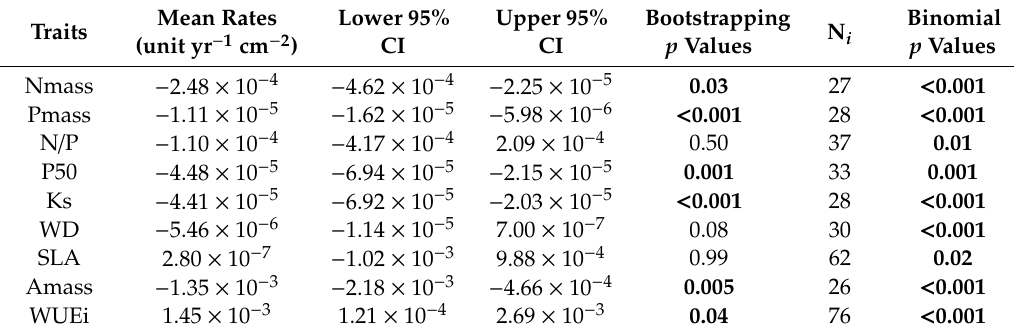
Table 1. Mean linear slope of regression in annual rates of change in quadrats’ functional composition vs. BA (basal area) in DHS plot. Traits